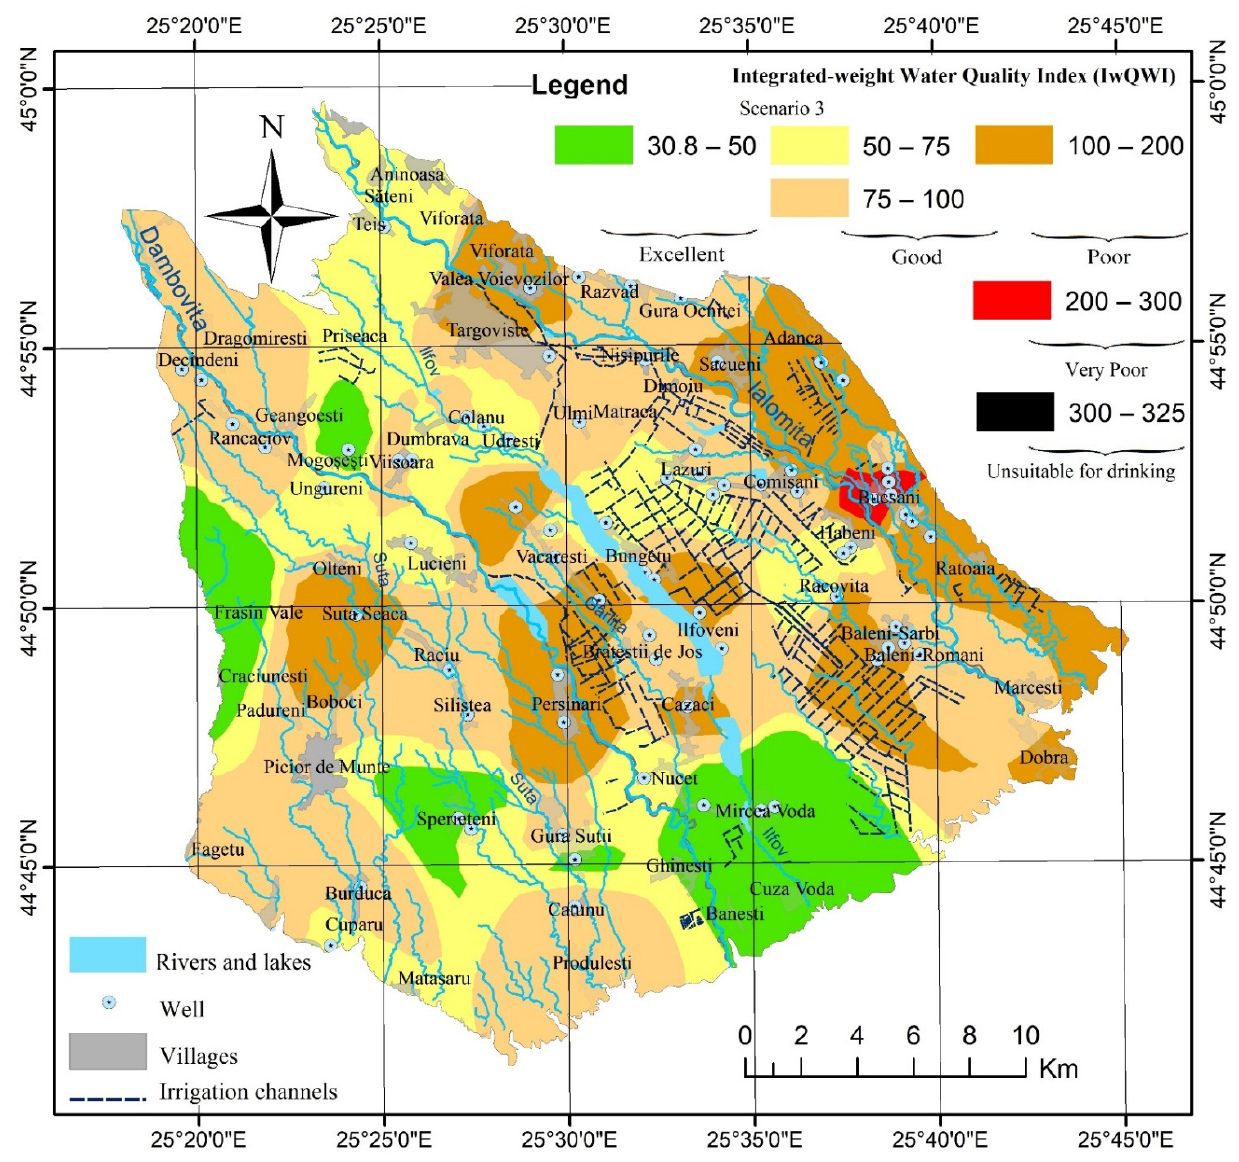
Figure 5. Map of Integrated weight Water Quality Index (IwWQI) in Târgovi ş te Plain.